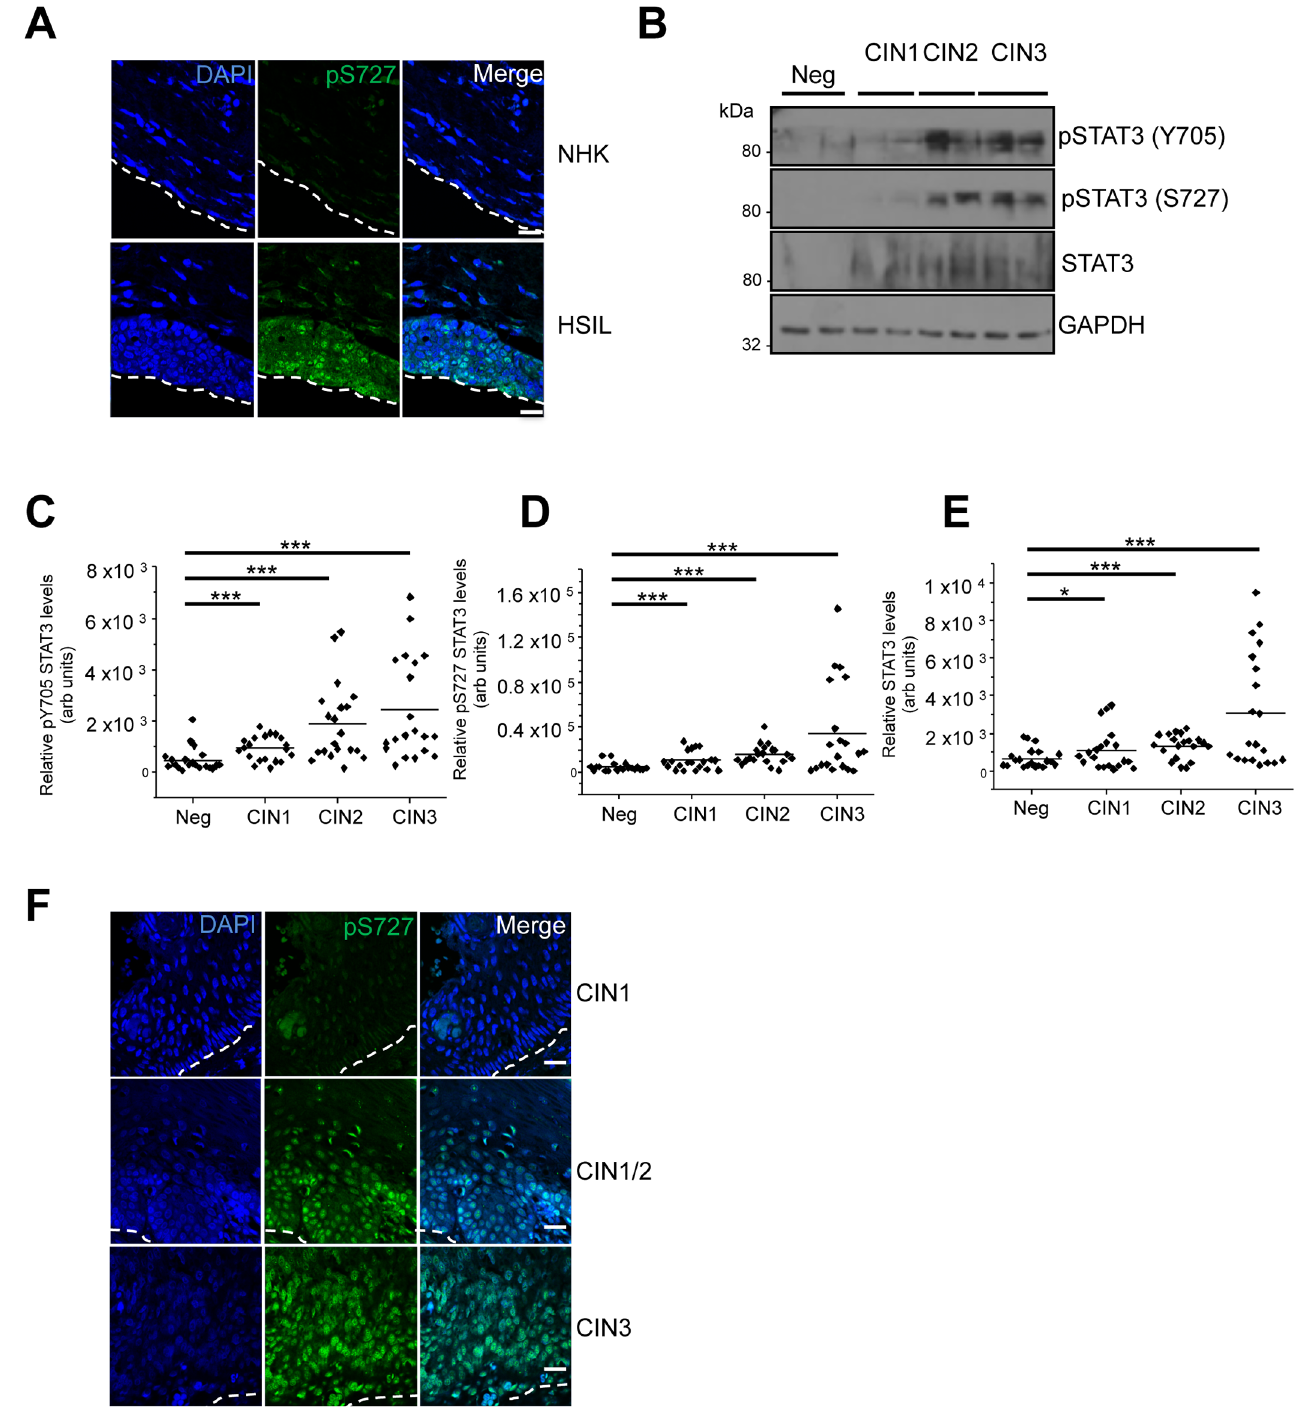
Fig 10. STAT3 expression and phosphorylation is increased in HPV-associated cervical disease. A) Representative immunofluorescence analysis of sections from organotypic raft cultures of NHK and a W12 cell line presenting with HSIL morphology detecting pS727 STAT3 levels (green). Nuclei were visualized with DAPI (blue) and the white dotted line indicates the basal layer. Images were acquired with identical exposure times. B) Representative western blots from cytology samples of CIN lesions of increasing grade analysed with antibodies specific for phosphorylated (Y705 and S727) and total STAT3 levels. GAPDH served as a loading control. C-E) Scatter dot plot of densitometry analysis of a panel of cytology samples. 20 samples from each clinical grade (neg, CIN I-III) were analysed by western blot and densitometry analysis was performed using ImageJ. Phosphorylated STAT3 levels were first normalised against total STAT3 levels before normalising against protein levels using GAPDH as a loading control. F) Representative immunofluorescence analysis of tissue sections from